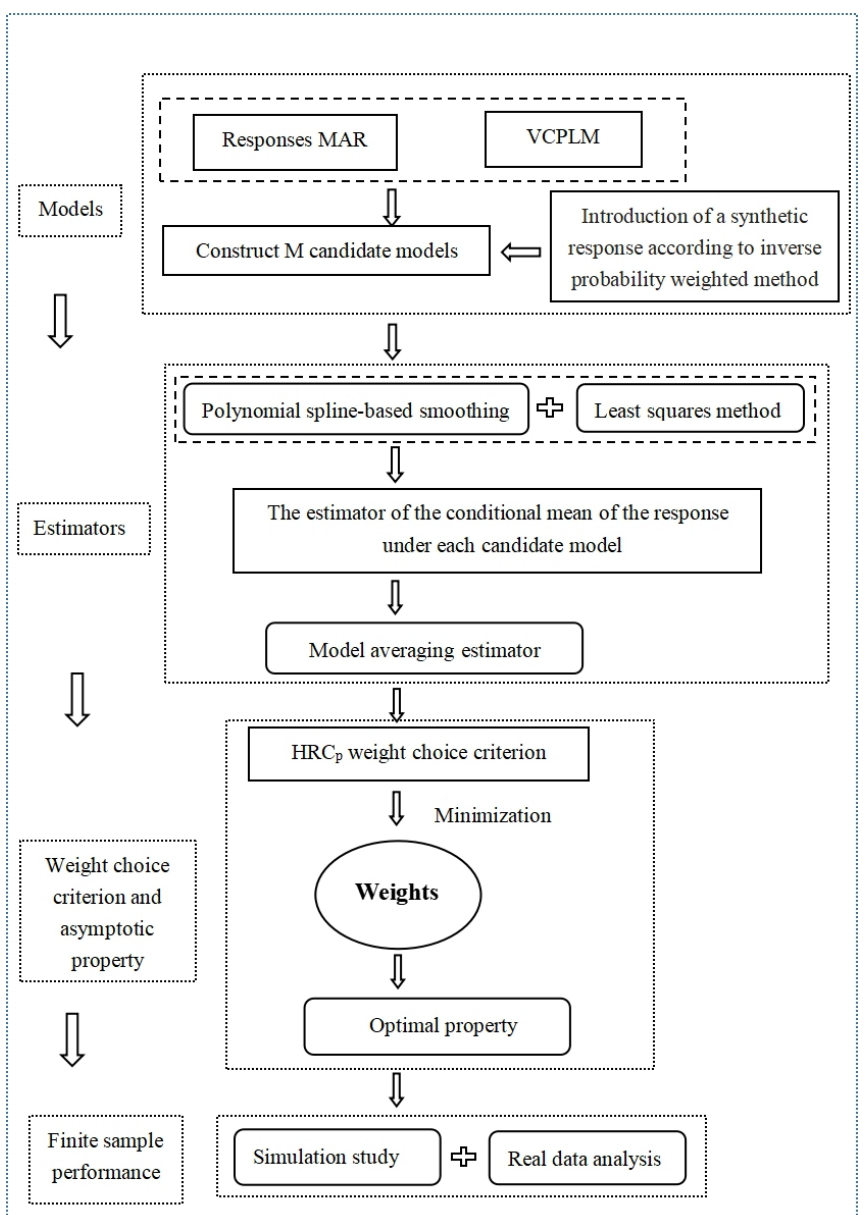
Figure 1. The flow chart of our